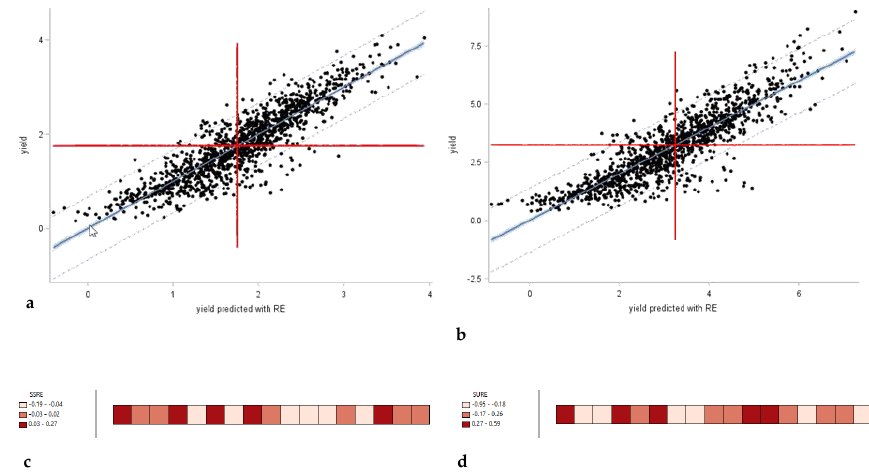
Figure 4. Selected publicly available space-time dataset visualizations. Top left ( a ): a scatterplot of the RE-based predicted and observed wheat yield values with fixed effects annual time intercepts. Top right ( b ): a scatterplot of the RE-based predicted and observed straw yield values with fixed effects annual time intercepts. Bottom left ( c ): a tertile map of the SSRE component. Bottom right ( d ): a tertile map of the SSRE component.